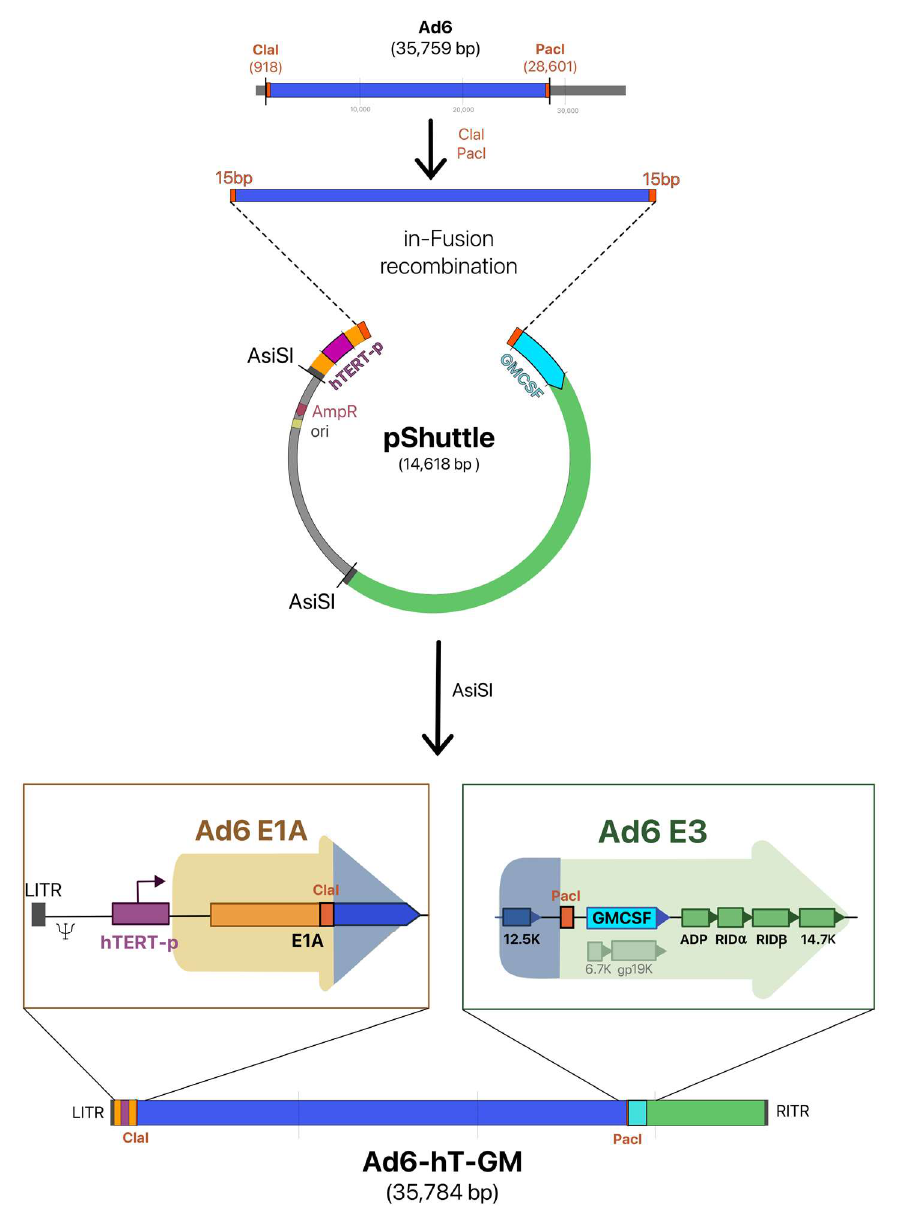
Figure 1. Construction of Ad6-hT-GM. pShuttle is based on pBR322 and contains the left part of the Ad6 genome from LITR to 1773 bp (shown in yellow) with hTERT promoter (shown in purple) replacing the native E1A promoter and the right part, from 27,576 bp to RITR (shown in green) with the GM-CSF transgene inserted instead of E3-6.7K and E3-gp19K genes (shown in cyan). pShuttle was linearized by amplification with primers containing 15 nucleotide homology arms (shown in orange). The Ad6 genome was digested with ClaI and PacI, and recombination between truncated genome and linearized pShuttle was performed by the In-Fusion kit. Ad6-hT-GM recombinant virus genome was then retrieved from the plasmid with the AsiSI. Expanded regions indicate modified Ad6-hT-GM genome regions.